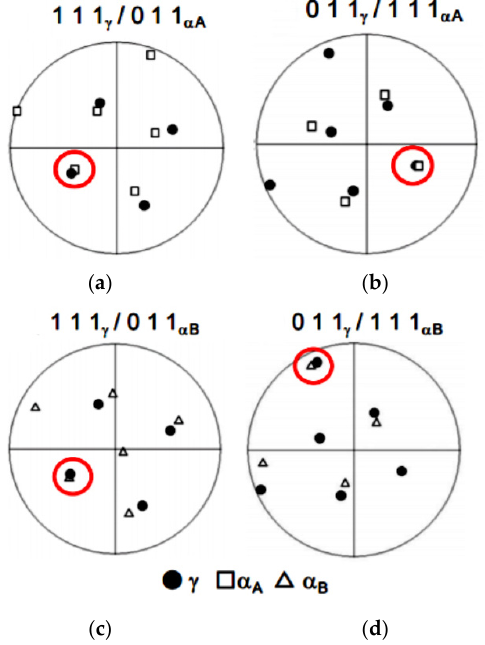
Figure 11. Stereographic projection of the 111 γ /011 α ( a , c ) and 011 γ /111 α ( b , d ) poles.